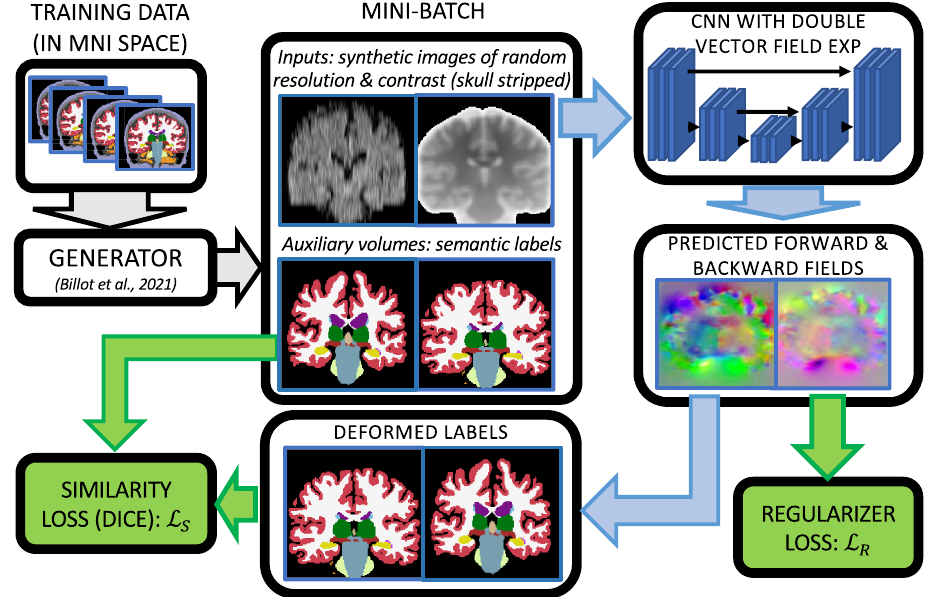
Figure 1. Overview of the training procedure used by EasyReg . The gray arrows follow the generator; the blue arrows follow the layers of the neural network; and the green blocks represent the different terms of the loss. We emphasize that the segmentations are used to compute the loss, but are not given as input to the CNN.